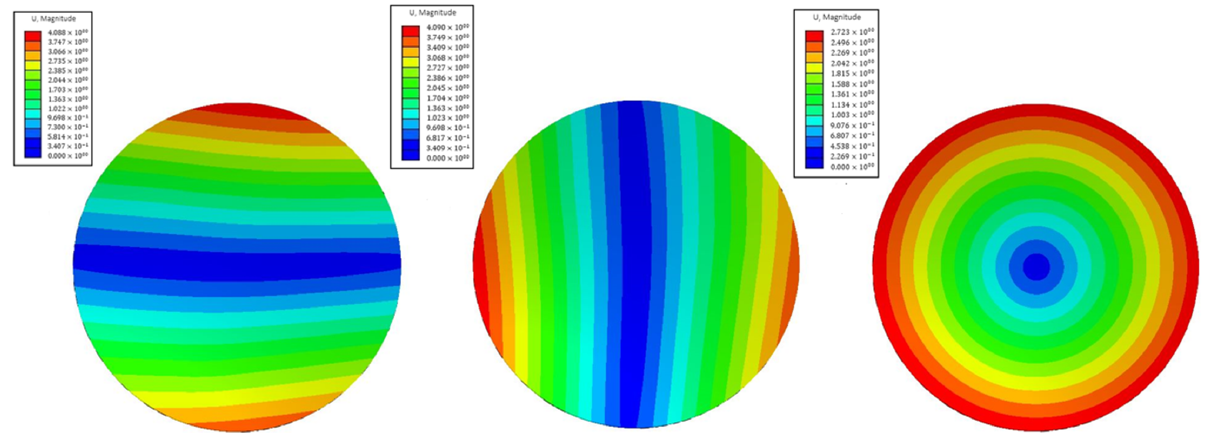
Figure 12. First three orders of the natural vibration mode cloud